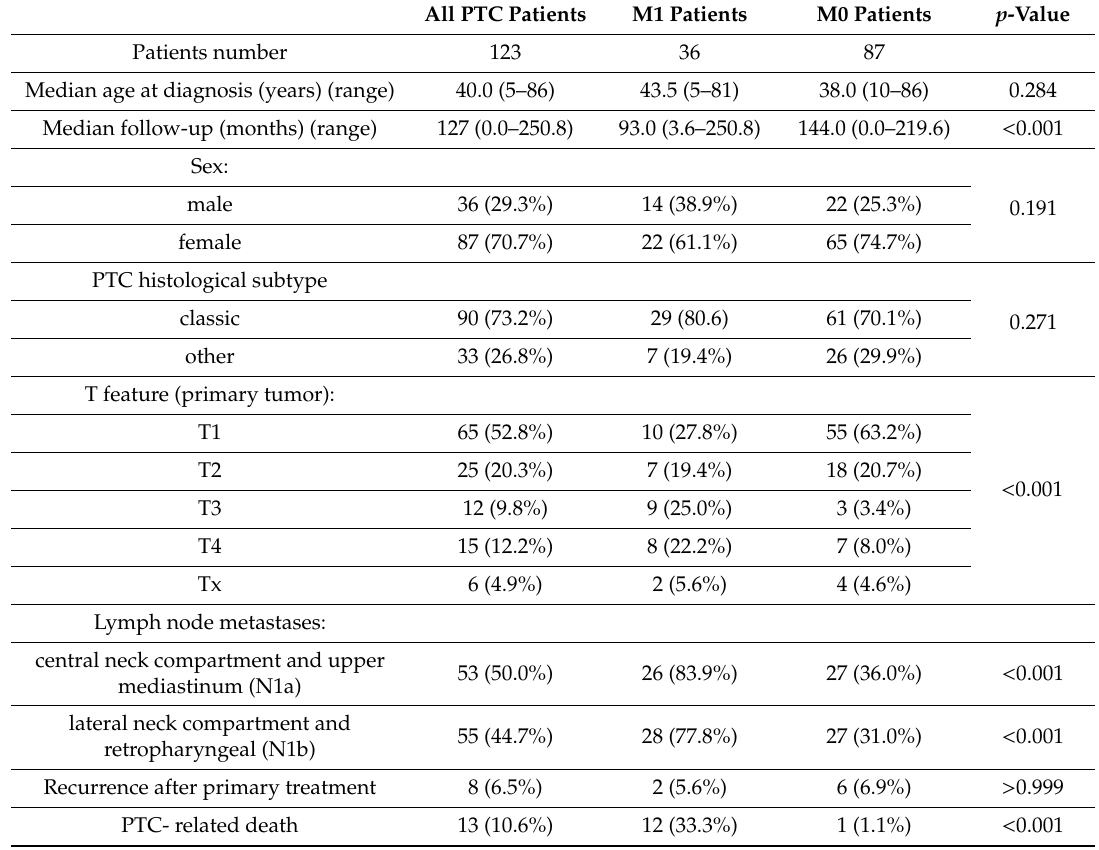
Table 5. Clinical characteristic of the whole microarray